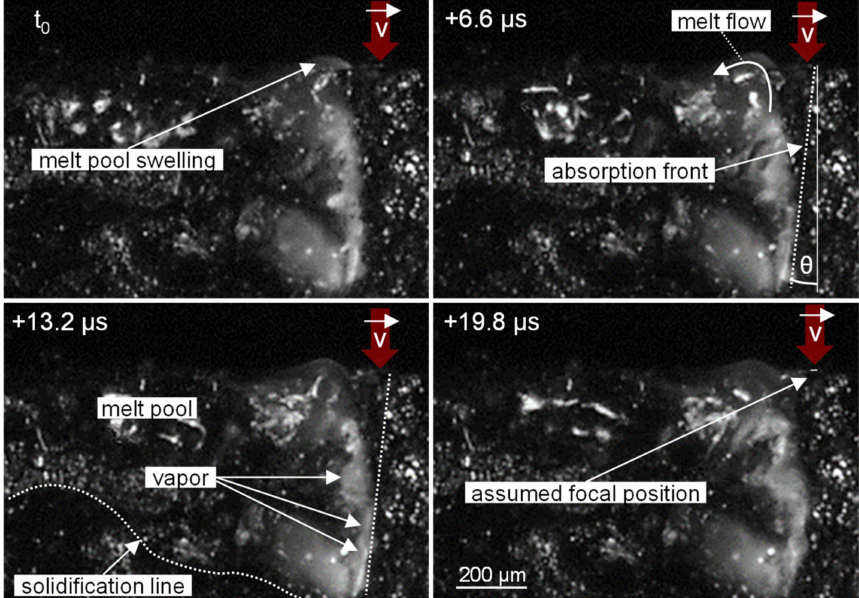
Figure 4. Snapshots from the footage of the high-speed records in half-section setup at a processing speed of 1 m/s.